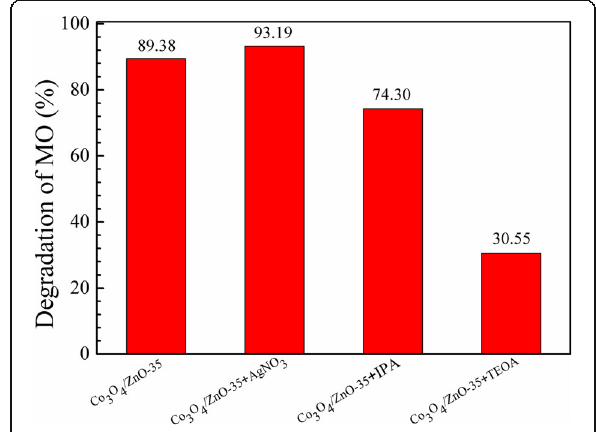
Fig. 12 Trapping experiment of active species during the photocatalytic degradation of MO with Co 3 O 4 /ZnO-35 under 72 h UV light irradiation